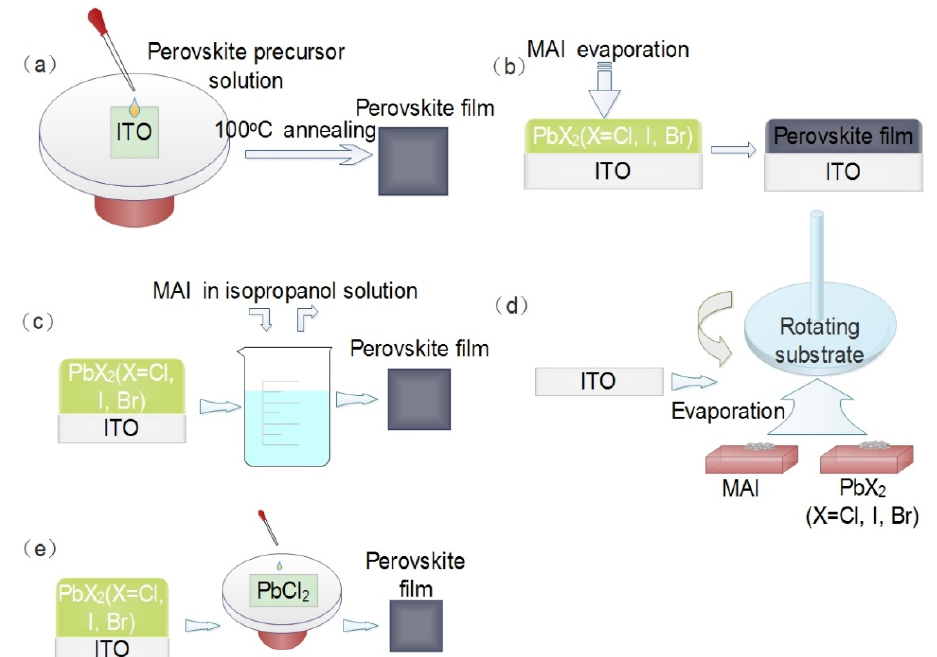
Figure 4. The preparation of MAPbX 3 (Cl, I, Br) films using different deposition methods: ( a ) a one-step solution process based on a mixture perovskite precursor solution, ( b ) a vapor-assisted solution process using CH 3 NH 3 I (MAI) organic vapors, ( c ) sequential deposition by soaking the PbX 2 (Cl, I, Br) into a MAI solution, ( d ) dual source co-evaporation using PbX 2 (Cl, I, Br) and MAI sources, ( e ) sequential deposition by dipping the MAI solution on the PbX 2 (Cl, I, Br).